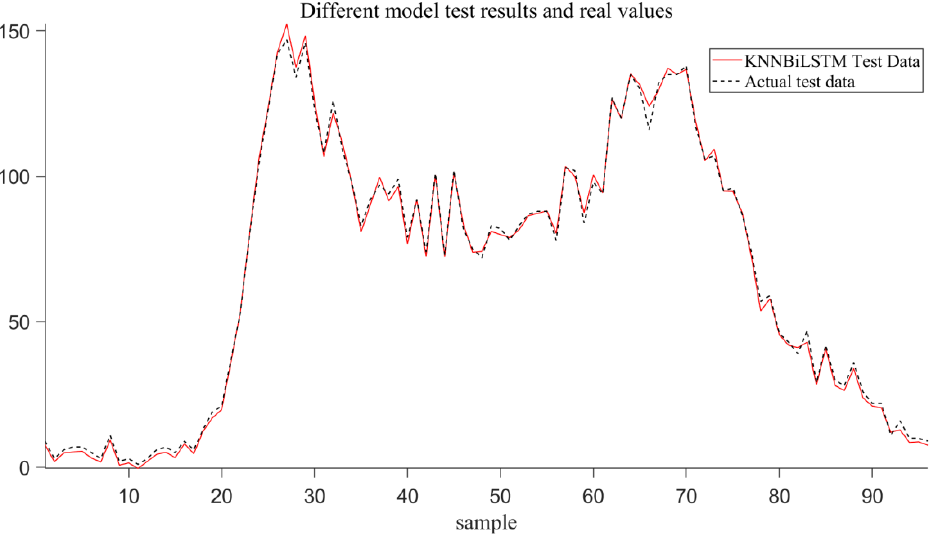
Figure 5. Screening one-day sample size prediction result.